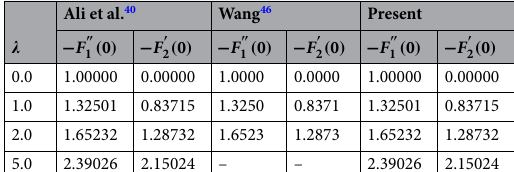
F ′ F ′′ 0 ) and 0 ) against various strength of (cid:31) at Ŵ 1 ( 2 ( − −